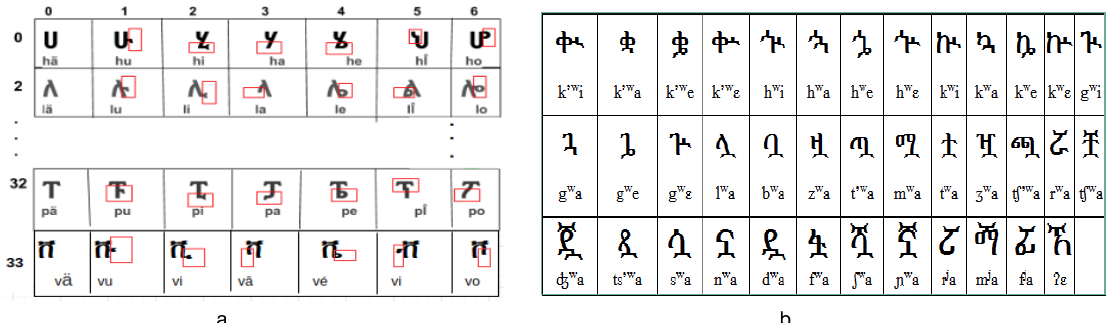
Figure 1. The shapes and structural formations of sample Amharic characters: ( a ) Basic Amharic characters with the orders of consonant–vowel variants (34 × 7), including the lately introduced Amharic character ( ª ). Characters in the first column are consonants and the others are derived variants (vowels) formed from each consonant by adding diacritics and/or removing part of the character, as marked with the red box. ( b ) Derived/labialized characters. Labialized characters marked with circles are also derived from consonant